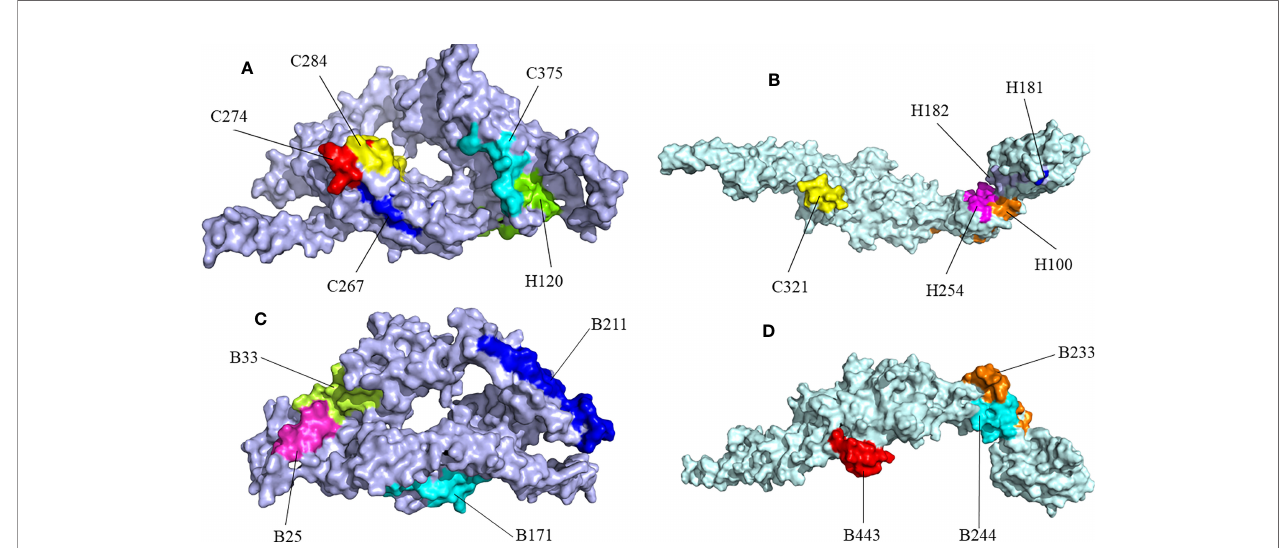
FIGURE 4 | Surface positions of fi nal selected epitopes on the three-dimensional (3D) models of the protein. (A) The Cytotoxicity T Lymphocytes (CTL) and Helper T lymphocyte (HTL) epitopes of CdeC. (B) The CTL and HTL epitopes of FliD. (C) The B-cell epitopes of CdeC. (D) The B-cell epitopes of FliD. Every CTL epitope is represented by a combination of C and its starting position. Every HTL epitope is represented by a combination of H and its starting position. Every B-cell epitope is represented by a combination of B and its starting position.